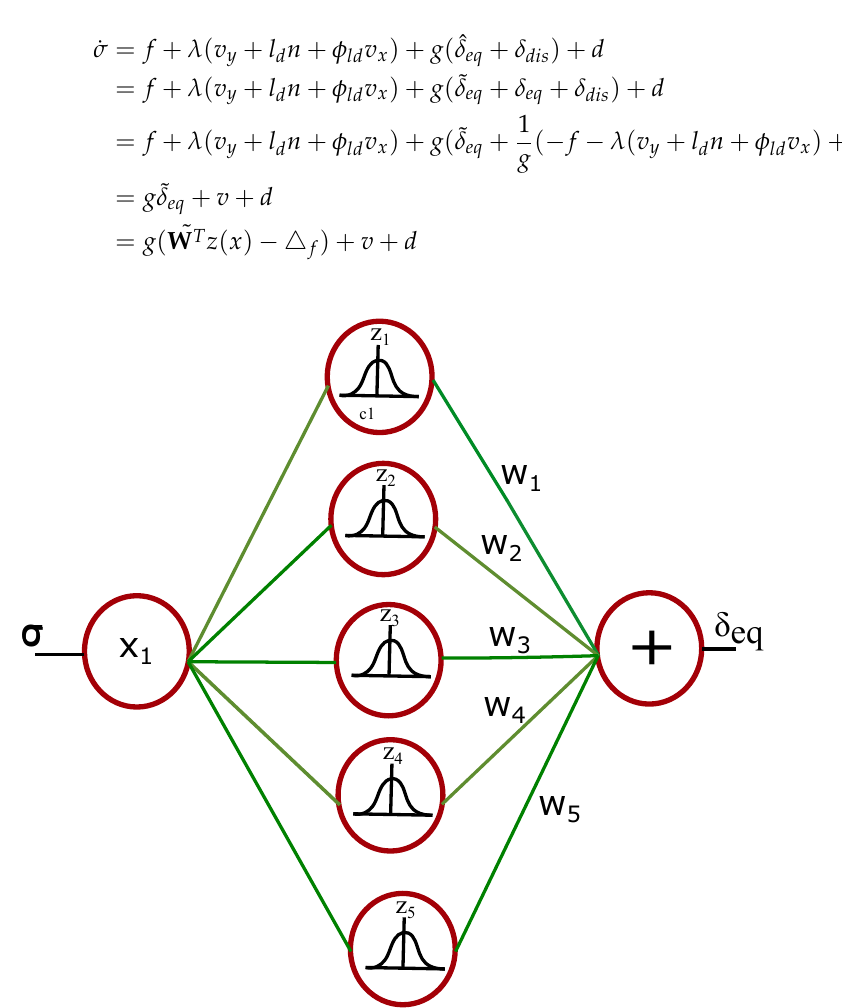
Figure 3. Structure of the